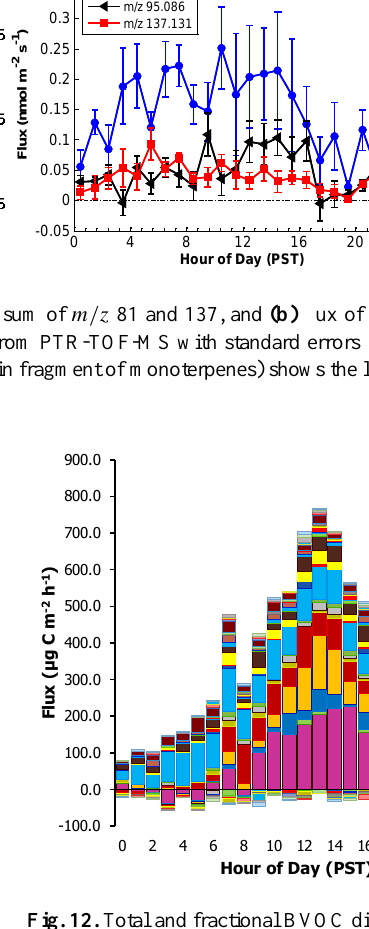
Fig. 11. Diurnal variation of m/z 61.027 (acetic acid) fluxes with standard errors.